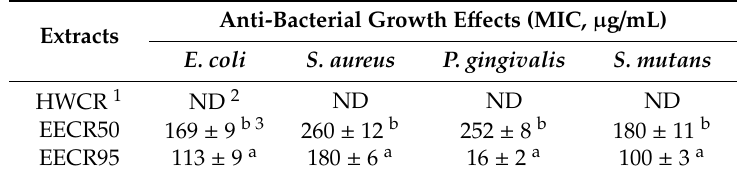
Table 8. The anti-bacterial growth e ff ects of hot water, 50 and 95% ethanol extracts from C. cajan roots.